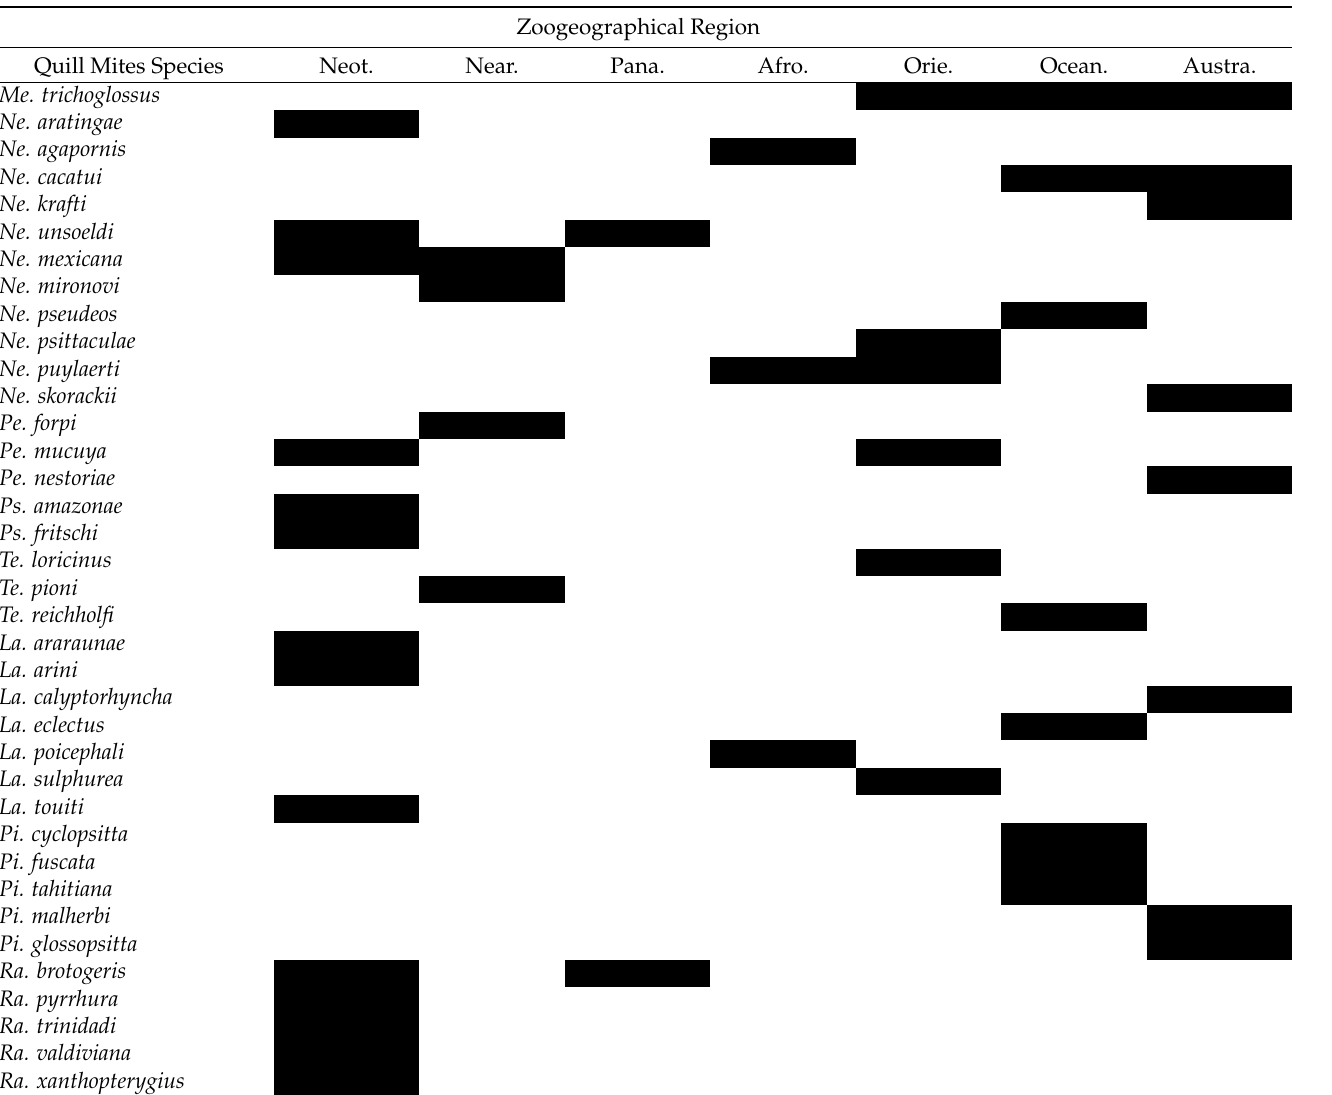
Table 6. Cont. Zoogeographical Region Quill Mites Species Neot. Near. Pana. Afro. Orie. Ocean.